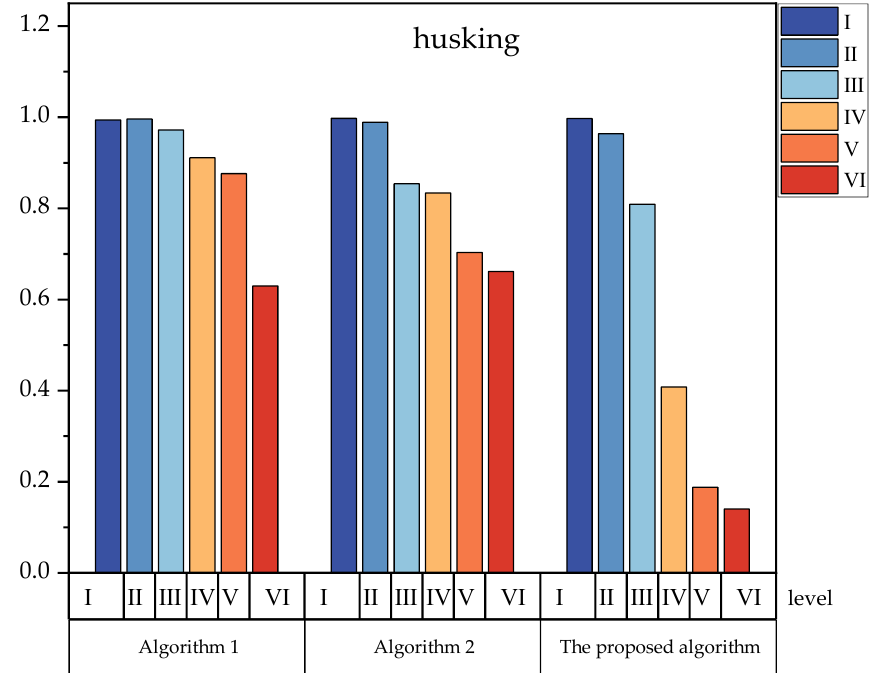
Figure 4. Histograms of the membership degrees of husking.